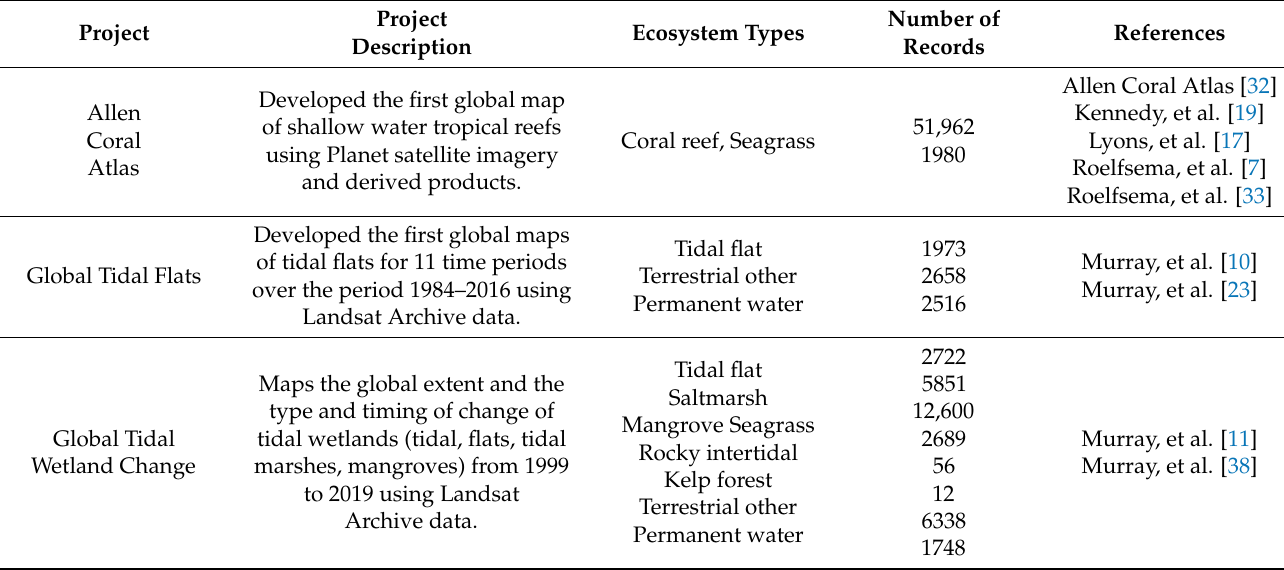
Table 2. The number of occurrence records in the coastTrain